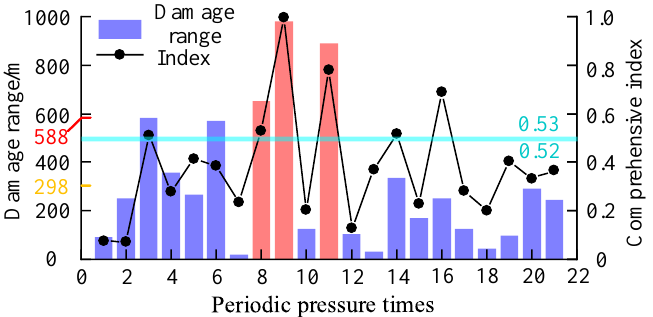
Figure 16. Comprehensive index early warning critical interval and effectiveness ( “ strong ” ).